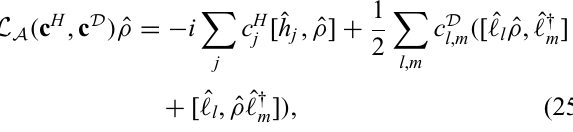
cesses are parametrized by an ansatz in Lindblad